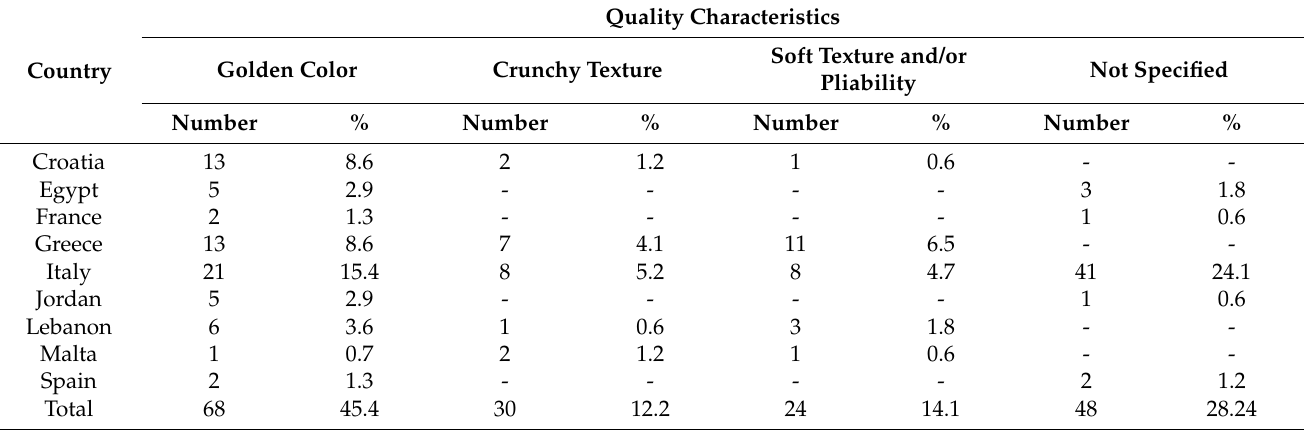
Table 9. Principal quality characteristics of flat breads. Multiple answers were admitted, because breads could show more quality characteristics at the same